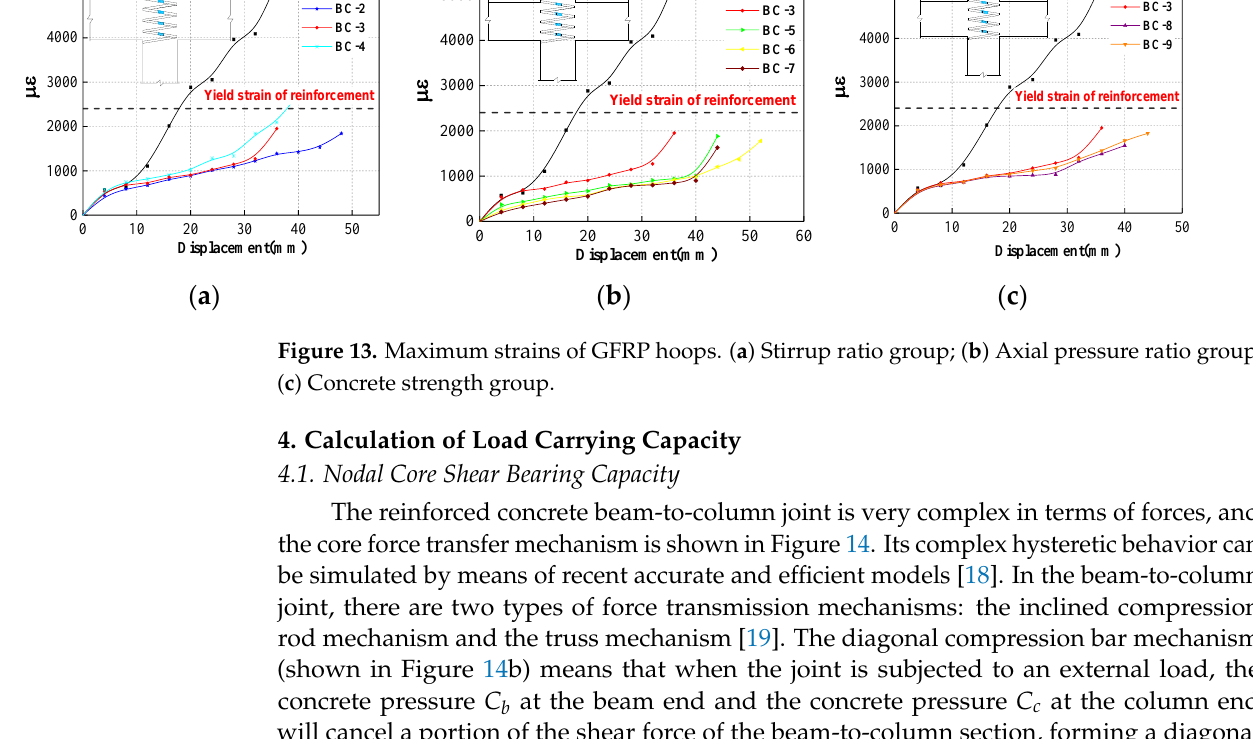
( c ) Figure 14. Shear transfer mechanism of joint core region. ( a ) Nodal force model; ( b ) Inclined lever mechanism; ( c ) Truss mechanism. Referring to the RC concrete beam-to-column joint model and the existing diagonal compression bar model, the shear force is defined as follows [21]: j